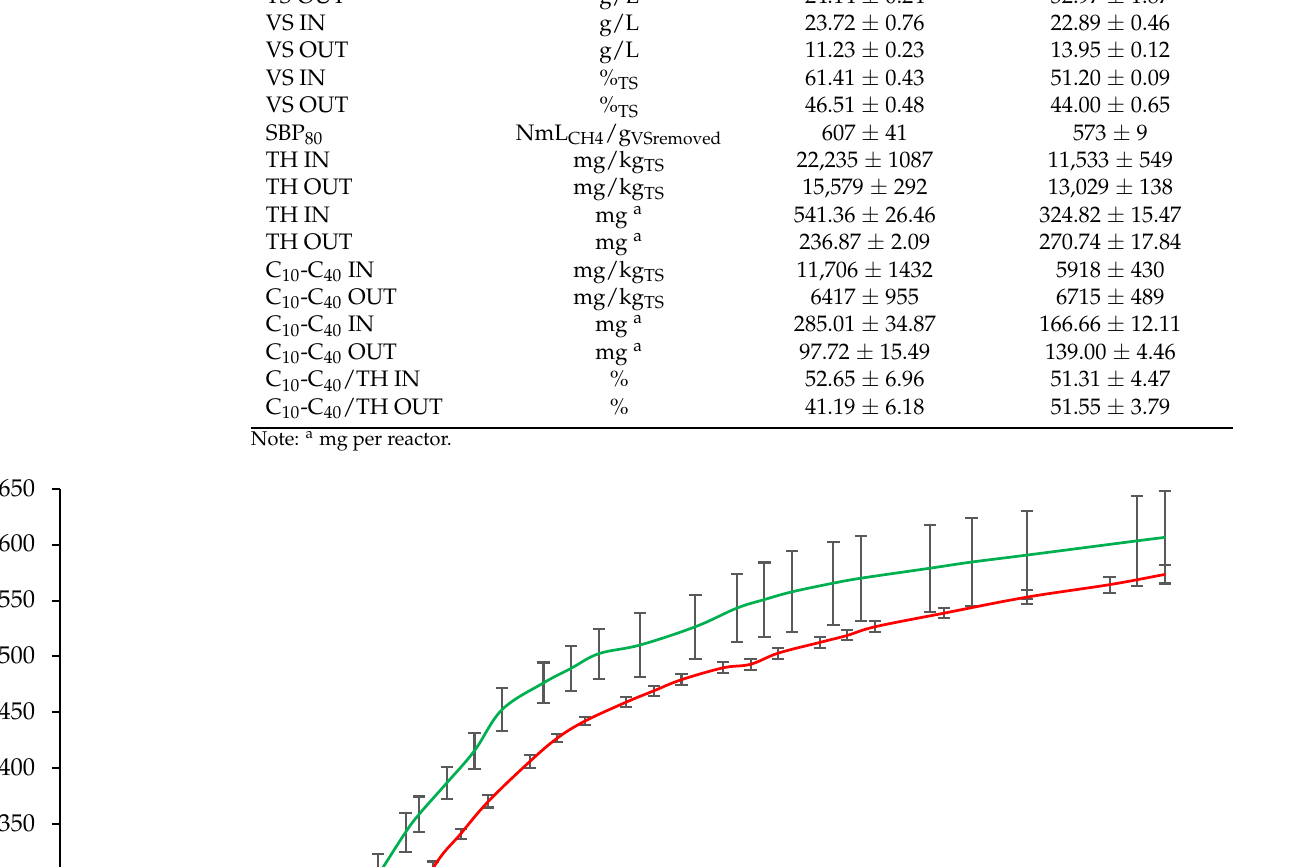
Table 1 . Parameters of RS and CS measured before (IN) and after (OUT) AD.